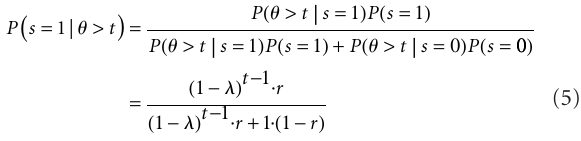
depend on the t